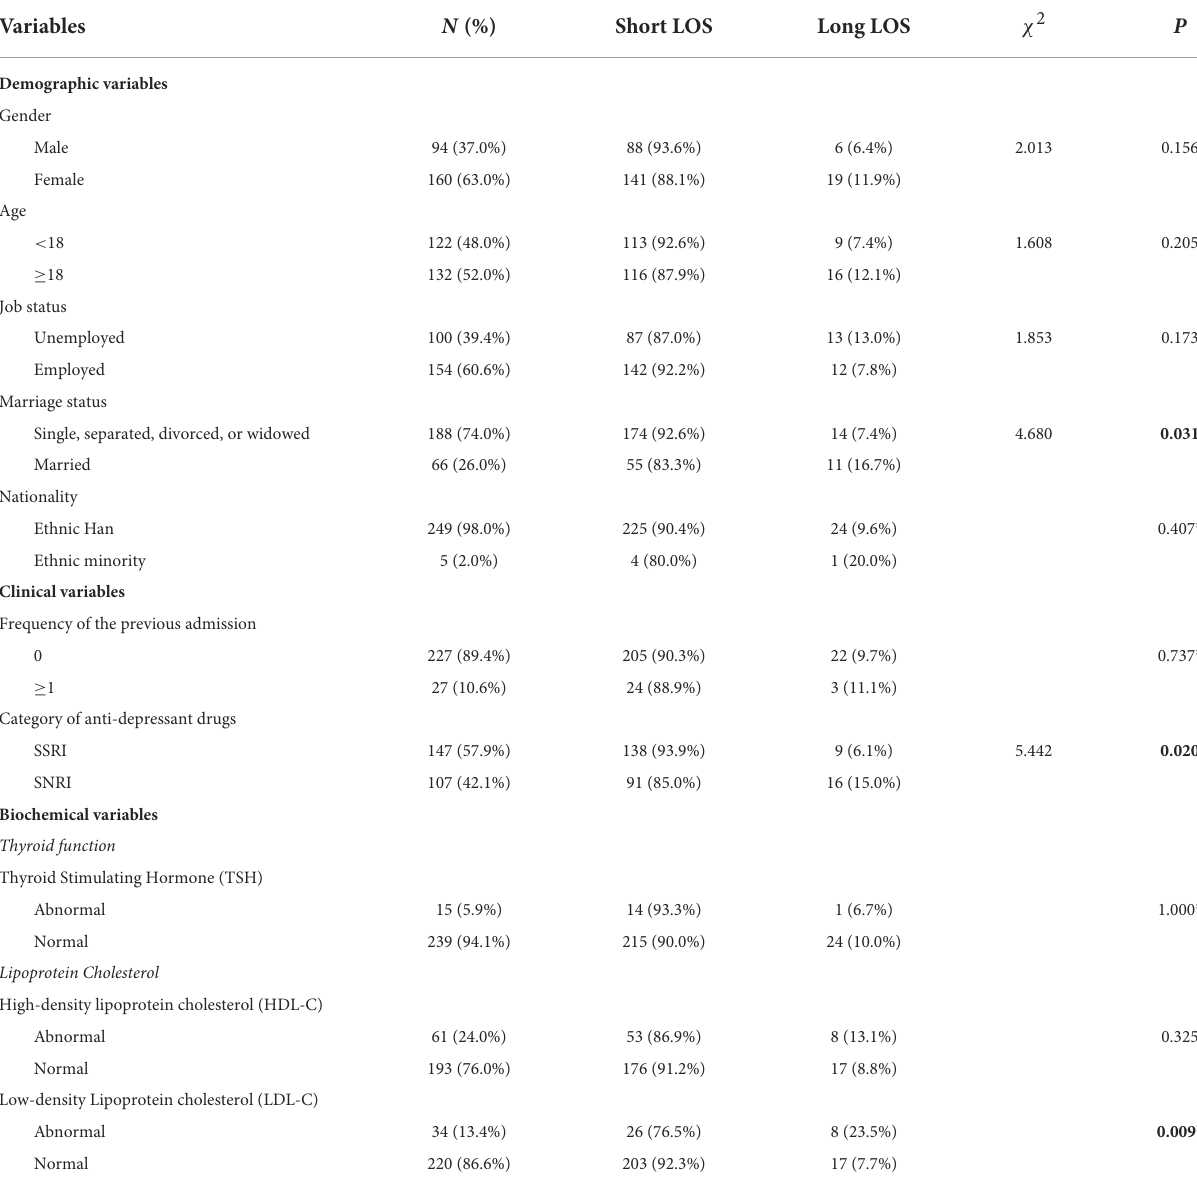
TABLE 1 Descriptive statistics and univariate analysis of variables related to the